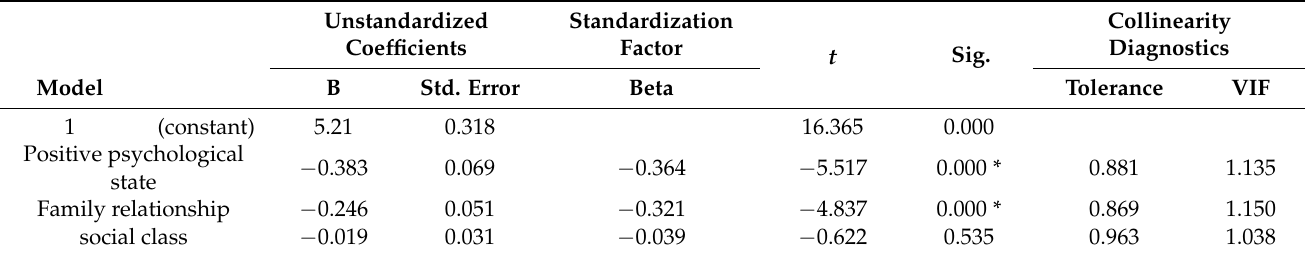
Table 4. Collinearity diagnostics of regression coefficient a in 2019.